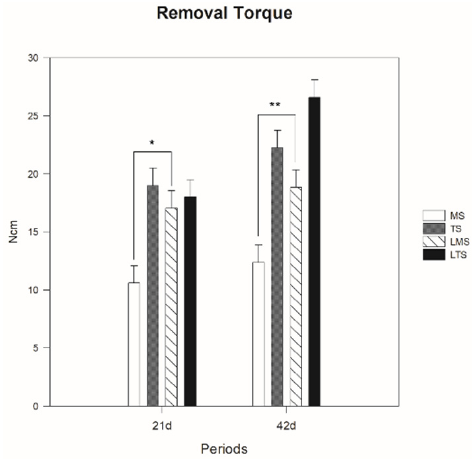
Figure 4. Mean values and standard deviation of removal torque between groups in the periods of 21 and 42 days. (*, ** p < 0.05).